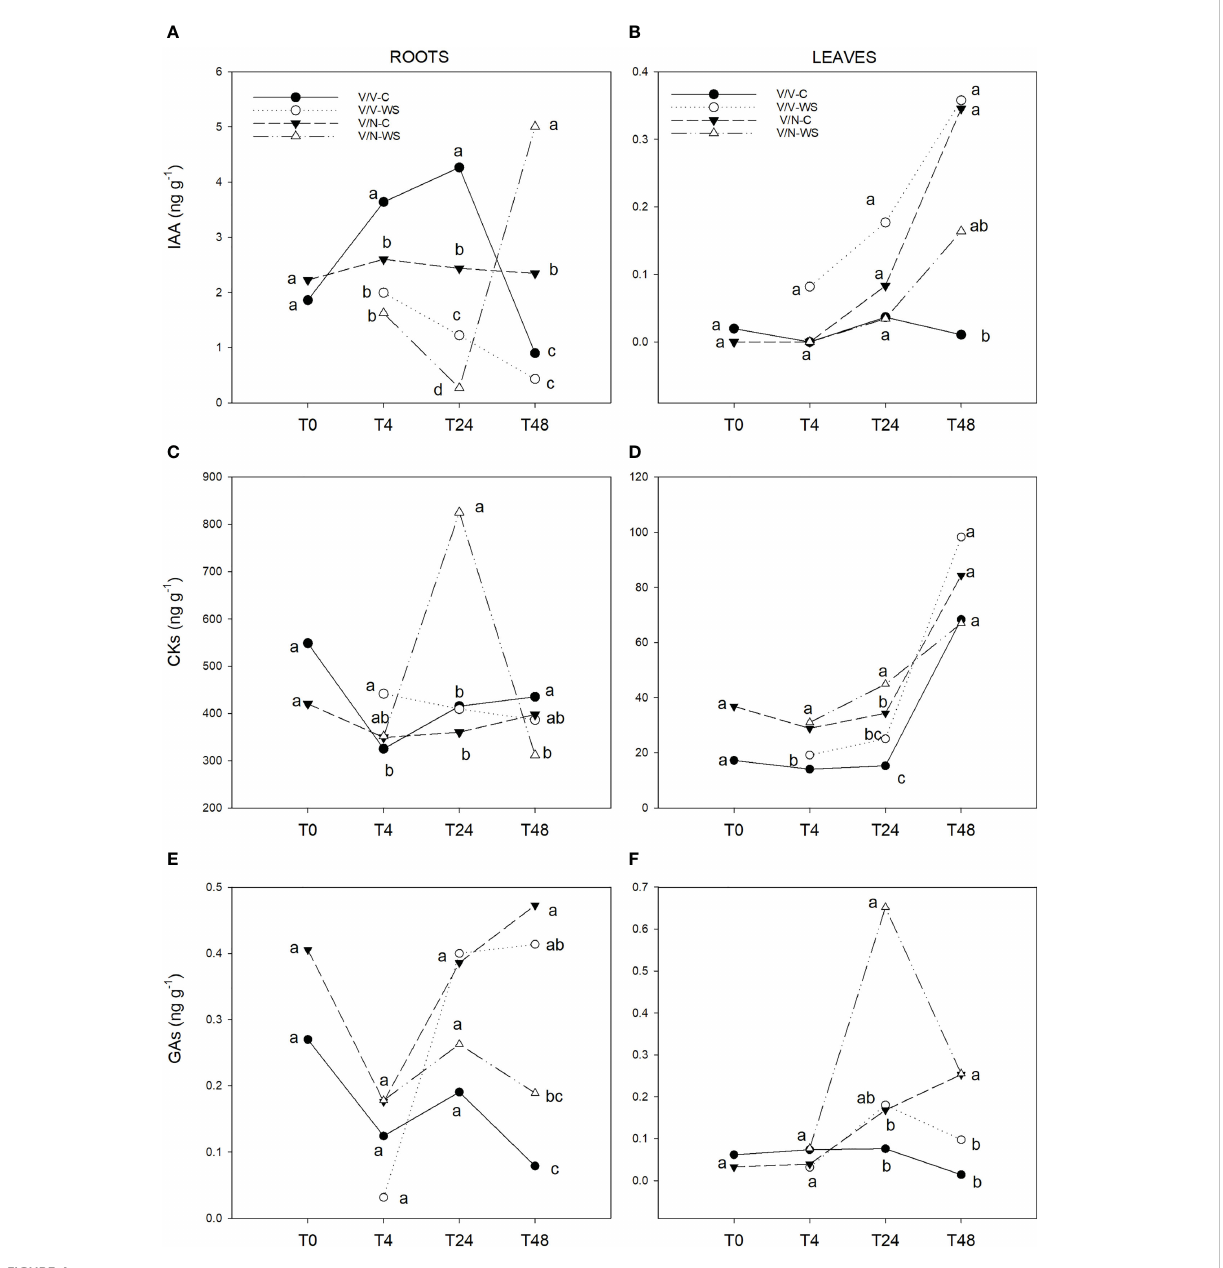
FIGURE 4 IAA (A, B) , CKs (C, D) and GAs (E, F) concentration in roots and leaves of self-grafted pepper plants (V/V) and the plants grafted onto NIBER ® (V/N) at 0% PEG (control, C) or 5% PEG (water stress, WS). Measurements were taken on T0, T4, T24 and T48 (hours after treatment with PEG began). Data are the mean values for n = 4. For each studied time, different letters indicate signi fi cant differences at P ≤ 0.05 (LSD